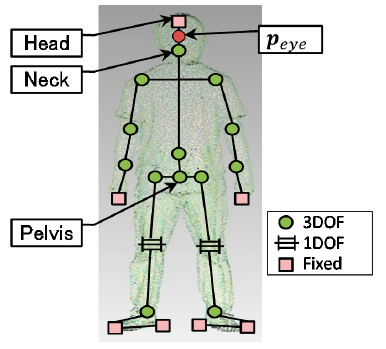
Figure 4. Link mechanism of DHM.